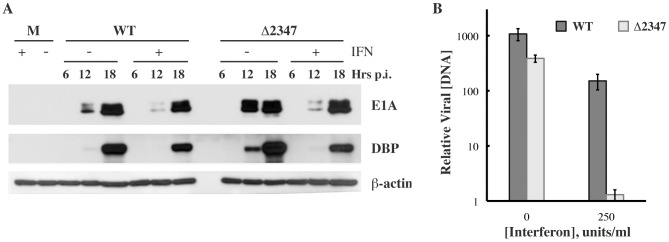
Effects of IFN on early reactions in the infectious cycle in the presence and absence of the E1B 55 kDa protein.(A) IFN treated and untreated NHBECs were infected with 5 p.f.u./cell AdEasyE1 (WT) or AdEasyEΔ23471 (Δ2347) and whole-cell lysates prepared after the periods indicated. The viral E1A proteins and DBP and cellular β-actin were examined by immunoblotting. (B) Nuclear DNA from IFN treated and untreated NHBECs infected with 5 p.f.u./cell AdEasyE1 (WT) or AdEasyE1Δ2347 (Δ2347) was isolated at 24 hrs. p. i. and the concentration of viral DNA measured by qPCR as described in Materials and Methods. The values shown were normalized relative to the input concentrations measured at 2 hrs. p. i., and represent the average and standard deviations calculated as described in Materials and Methods of two independent experiments.